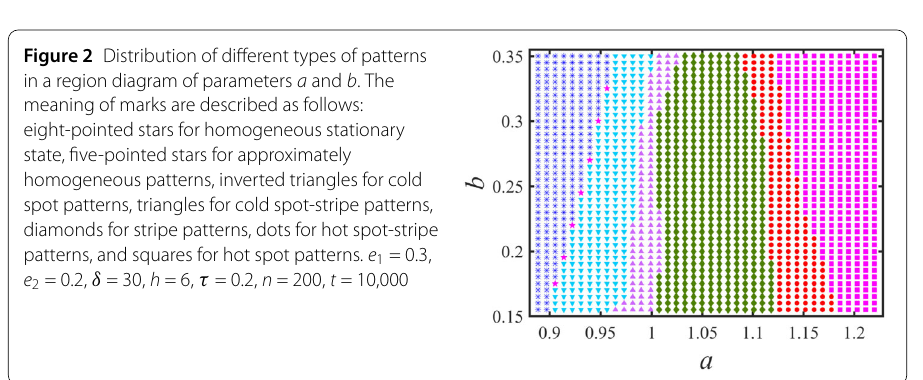
Figure 1 Various self-organized patterns induced by Turing instability under different a values, ( a ) approximately homogeneous pattern, ( b ) cold spot pattern, ( c ) cold spot-stripe pattern, ( d ) stripe pattern, ( e ) hot spot-stripe pattern, ( f ) hot spot pattern. The other parameter values are given as e 1 = 0.3, e 2 = 0.2, b = 0.1781, δ = 30, h = 6, τ = 0.2, n = 100, t = 10,000